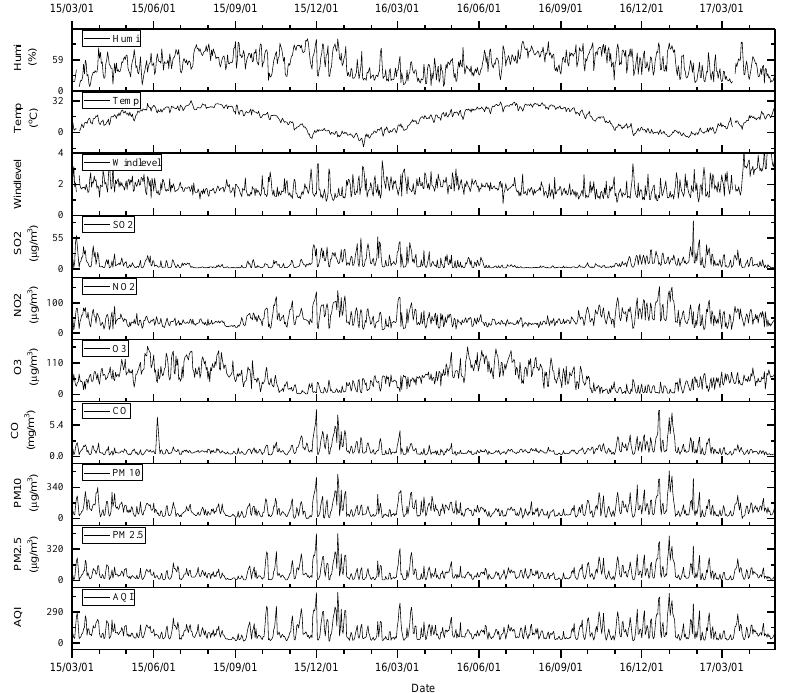
Date Figure 2. The number of daily observations during the study period. Figure 2. The number of daily observations during the study period. Figure 2. The number of daily observations during the study period.